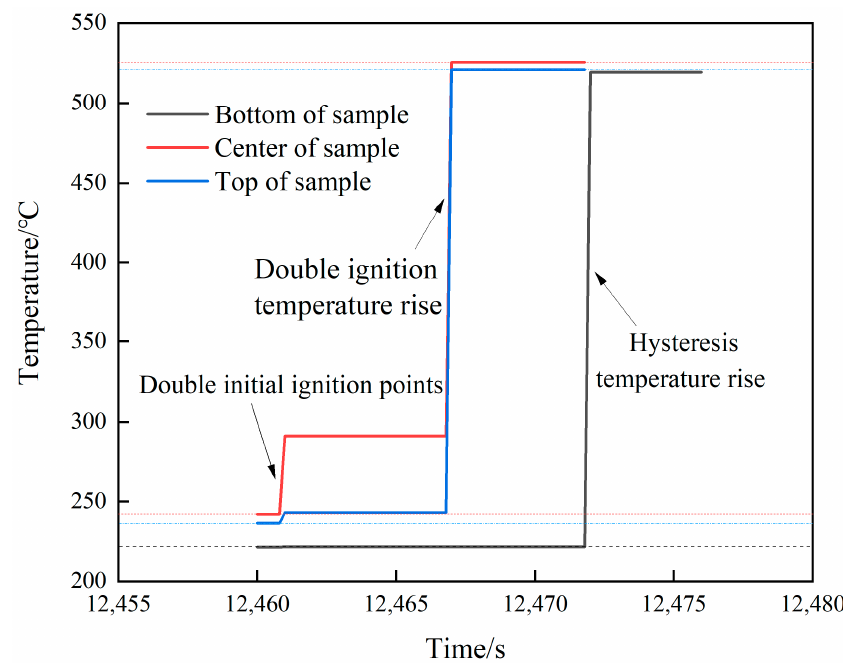
Figure 10. Temperature–time curve of shot 3.